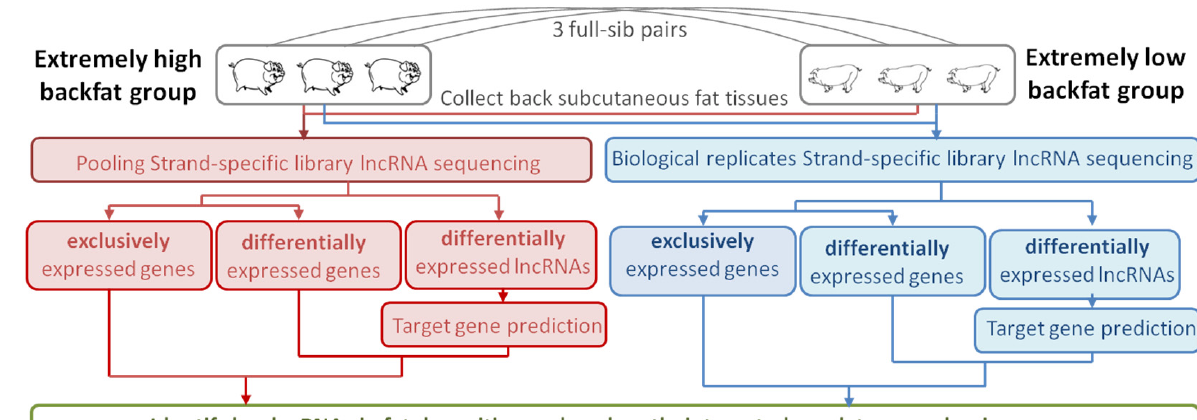
Figure 1. Experimental design of the current study.